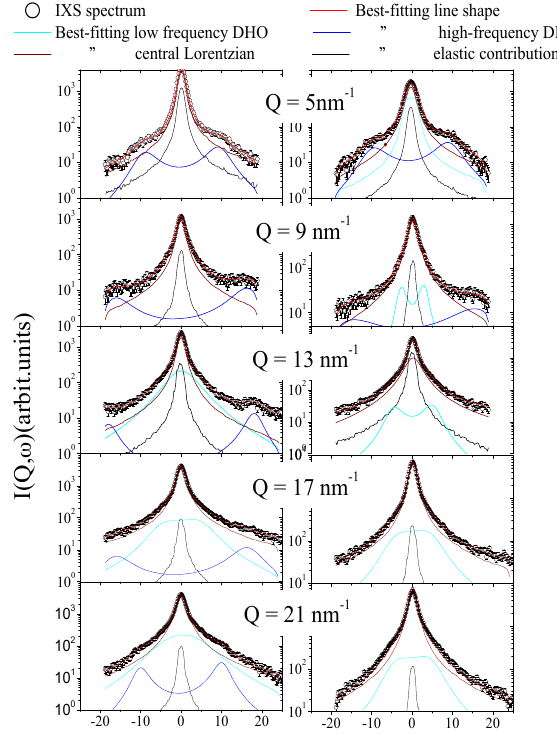
Figure 2. The IXS spectra of the Au-NP suspension ( left column ) and the pure water ( right column ) are compared with best fit lineshapes and the individual spectral components defined in Equation (1), as indicated in the